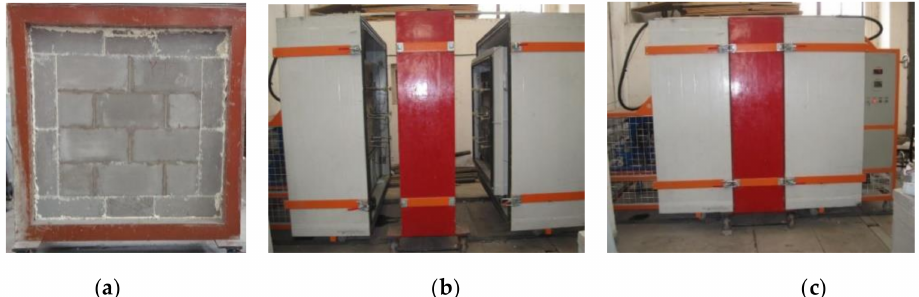
Figure 4. Testing device and installed specimen for thermal conductivity: ( a ) installed specimen; ( b ) internal meters; ( c ) close state of device.